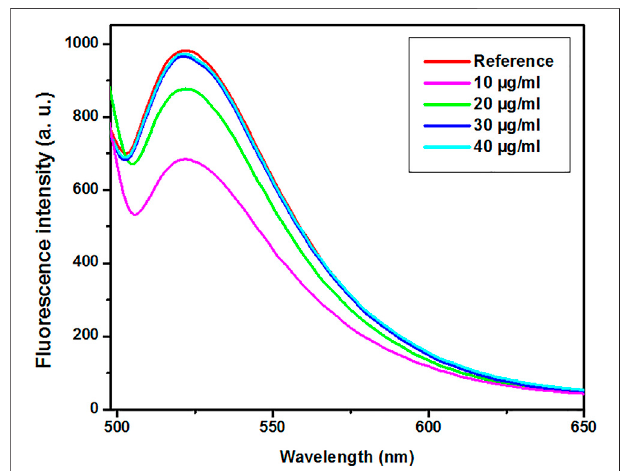
FIGURE 3 | The fl uorescence emission spectra of biotin-4- fl uorescein after adding various concentrations of H-1-biotin. Reference (Biotin-4- fl